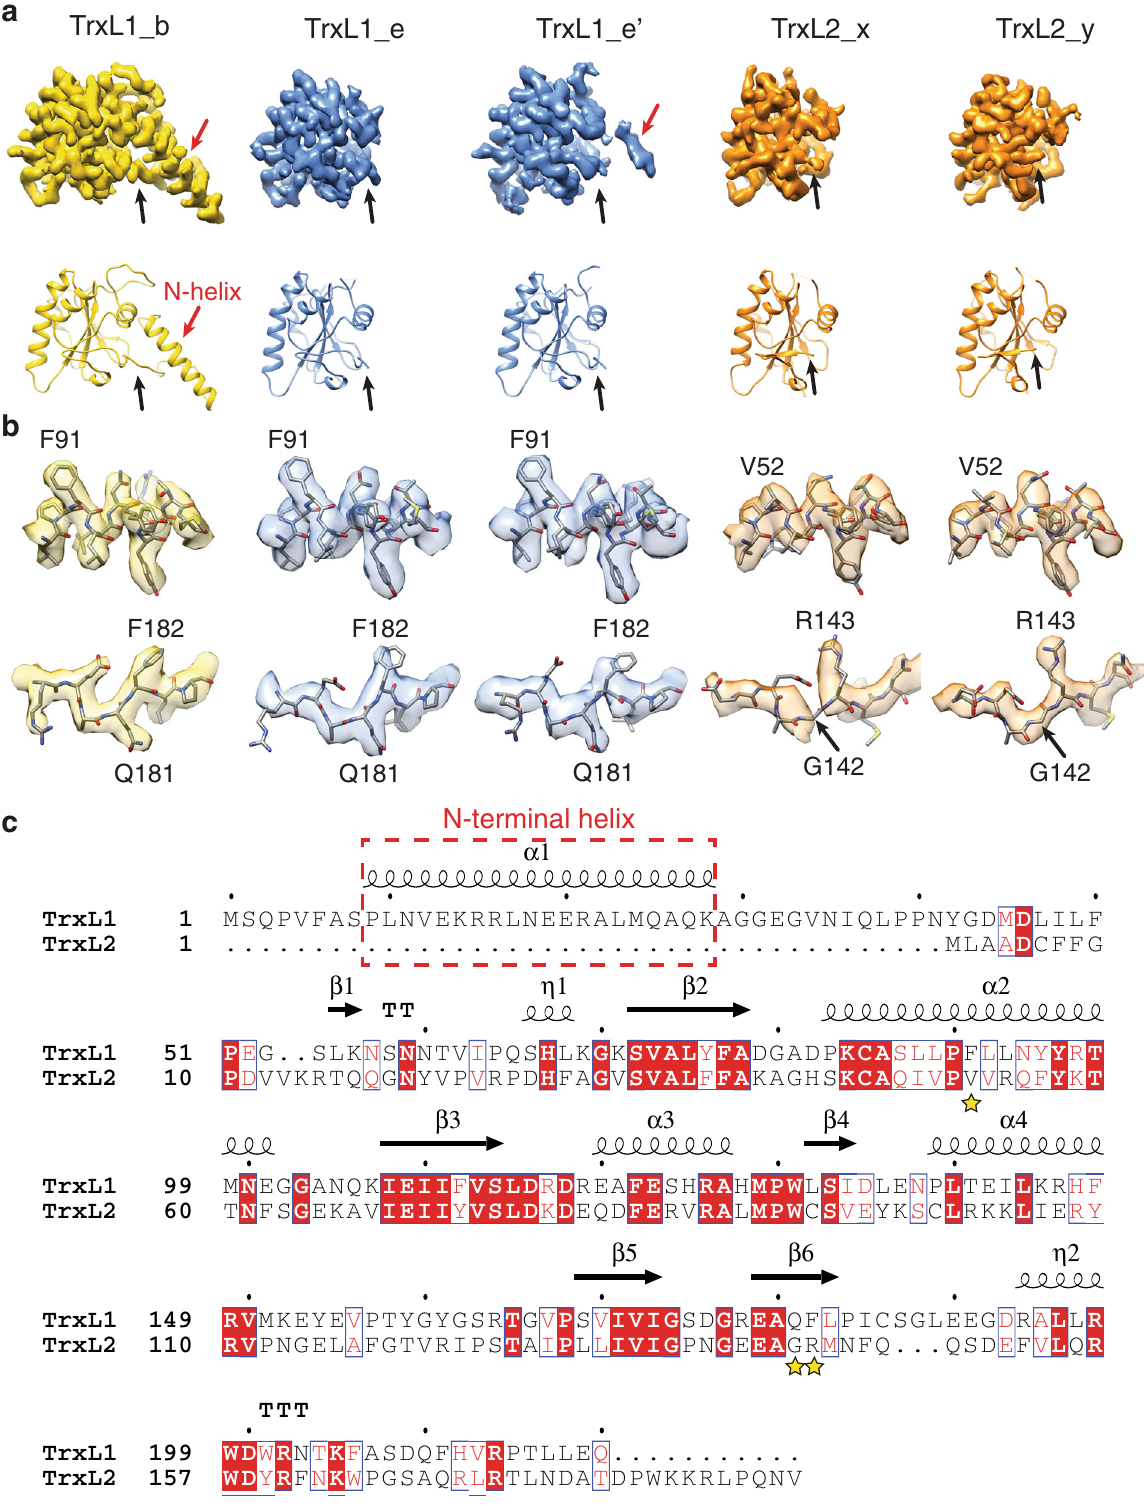
Fig. 2 TrxL1 and TrxL2. a Atomic models and segmented cryo-EM densities for TrxL1 (gold and blue) and TrxL2 (orange) at different locations as indicated in Fig. 1c. The black arrows highlight the distinct appearances of the N-termini of TrxL1 and TrxL2. b Side-chain densities of three residues (TrxL1: F91, Q181, and F182) that distinguish TrxL1 from TrxL2. DeepEMhancer-sharpened maps (see “ Methods ” ) are used for visualization. c Sequence alignment of TrxL1 and TrxL2. Secondary structure elements of TrxL1 are shown above the sequences. The three residues shown in (b) are marked by yellow